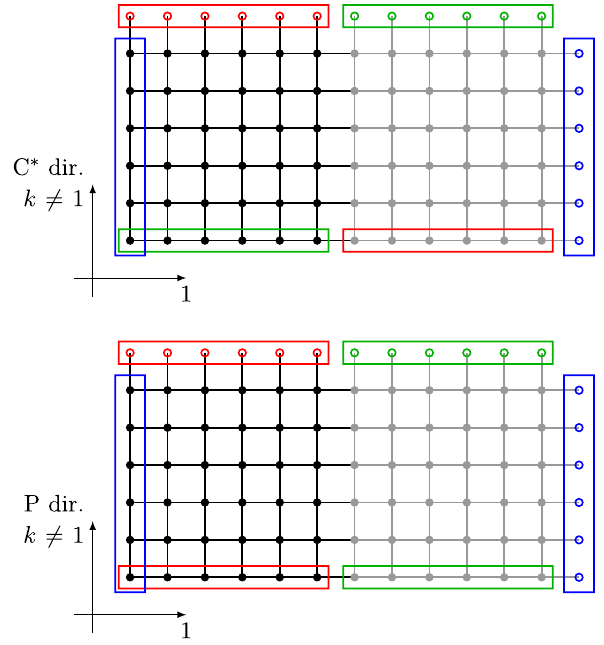
Fig. 2 Global geometry of extended lattice. The top diagram rep- resents a section of the extended lattice along a ( 1 , k ) plane where k = 2 , 3 is a direction with C ∗ boundary conditions. All fields are periodic along the extended direction 1. C ∗ boundary conditions in the direction k = 2 , 3 are replaced by shifted boundary conditions in the extended lattice. Shifted boundary conditions are imposed by prop- erly defining the nearest neighbours of boundary sites. Empty circles in the red (resp. green, blue) rectangle have to be identified with the corresponding solid circles in the red (resp. green, blue) rectangle. The bottom diagram represents a section of the extended lattice along a ( 1 , k ) plane where k = 2 , 3 is a periodic direction. In both diagrams , the black circles represent the sites of the physical lattice, and the grey circles represent the sites of the mirror